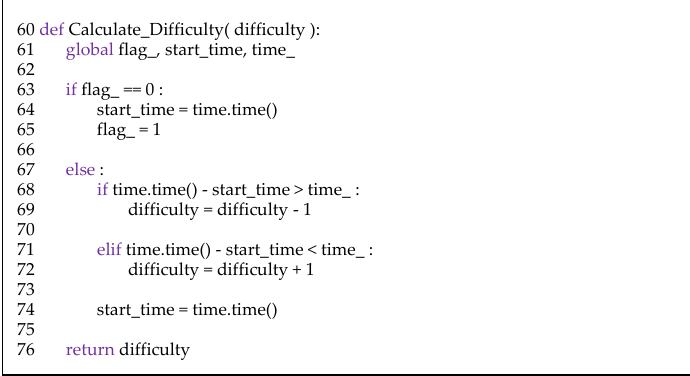
Figure 12. Implementation of difficulty adjustment.